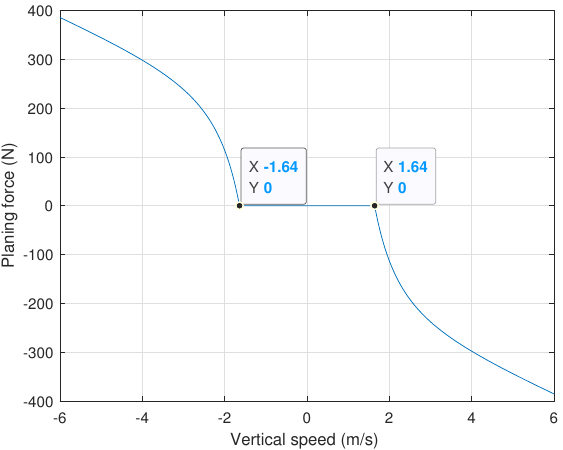
Figure 3. Planing force term versus the vertical speed w .